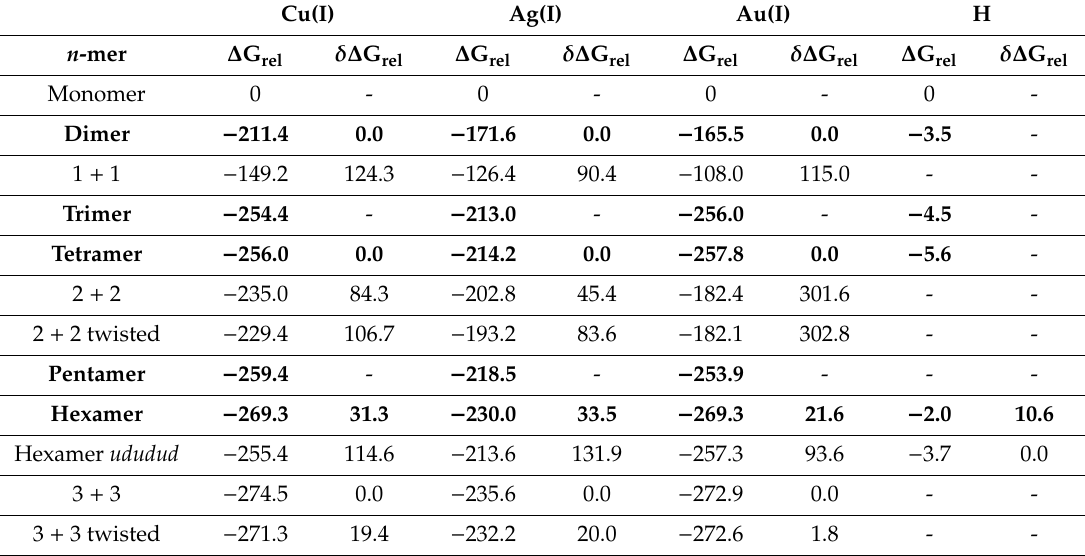
Table 5. Relative free energies per monomer, ∆ G rel and δ ∆ G rel , in kJ · mol − 1 , of the metallacycles formed by the parent pyrazolate ligand and the coinage metals M = Cu(I), Ag(I) and Au(I): (pzM) n for n = 2, 3, 4, 5 and